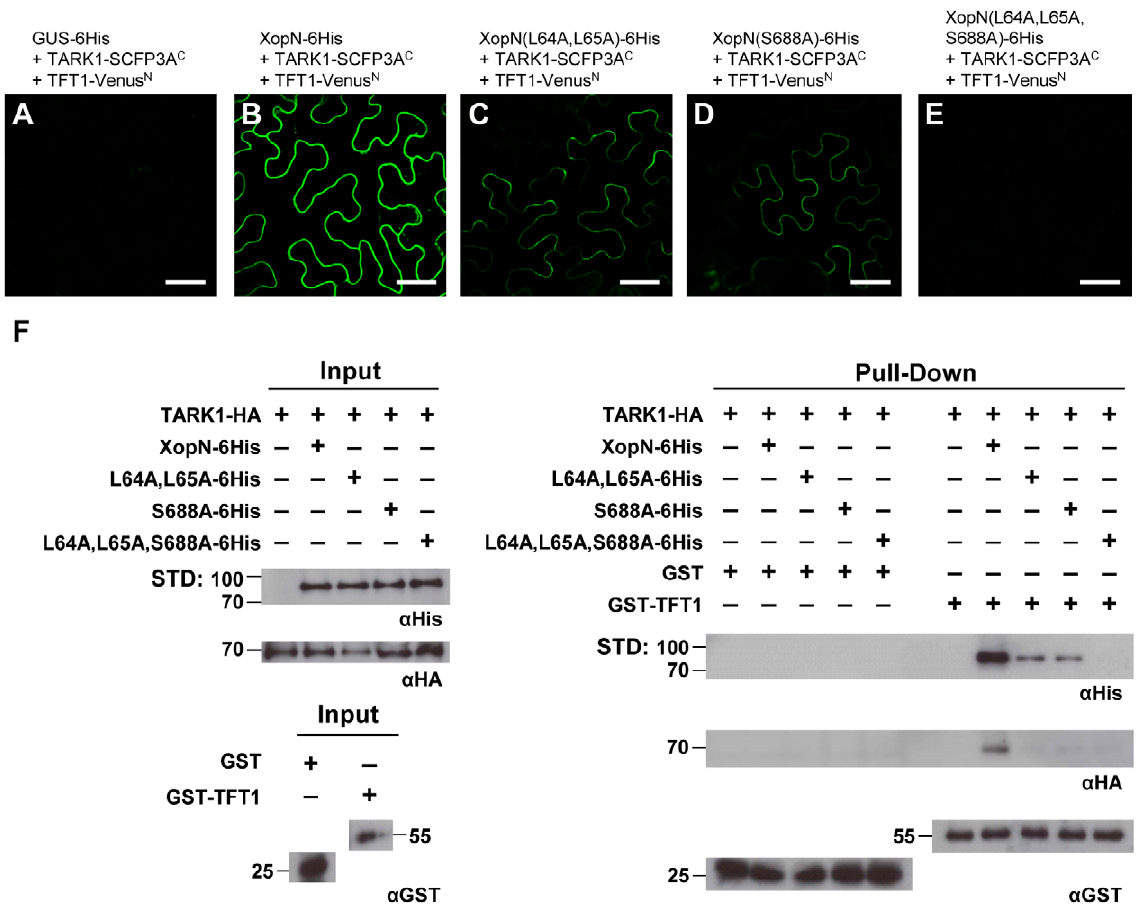
Figure 9. XopN promotes TARK1 and TFT1 binding in N.benthamiana . ( A-E ) BiFC analysis of TARK1/TFT1 interactions in N. benthamiana leaves in the presence of wild type and mutant XopN protein. Leaves were hand-infiltrated with a suspension (6 6 10 8 CFU/mL total) of three A. tumefaciens strains expressing different fusion proteins: ( A ) GUS-6His + TARK1-SCFP3A c + TFT1-Venus N ; ( B ) XopN-6His + TARK1-SCFP3A c + TFT1-Venus N ; ( C ) XopN(L64A,L65A)-6His + TARK1-SCFP3A c + TFT1-Venus N ; ( D ) XopN(S688A)-6His + TARK1-SCFP3A c + TFT1-Venus N ; ( E ) XopN-(L64A,L65A,S688A)-6His +- TARK1-SCFP3A c + TFT1-Venus N . Cells were visualized by confocal microscopy at 48 HPI at 63X. White bar=40 m m. ( F ) GST-TFT1 affinity purification of TARK1 and XopN in vitro . GST or GST-TFT1 was incubated with N. benthamiana leaf extracts containing TARK1-HA 6 vector, XopN-6His or mutant XopN-6His ( i.e. XopN(L64A,L65A)-6His, XopN(S688A)-6His, or XopN(L64A,L65A,S688A)-6His). Proteins were purified using glutathione sepharose and analyzed by immunoblot analysis using anti-His, anti-HA, and anti-GST sera. Protein input levels are shown on the left. GST and GST-TFT1 pull-downs are shown on right. Expected protein MW: GST=28 kDa; GST-TFT1=56.5 kDa; TARK1-HA=67.9 KDa; XopN(L64A,L65A)-6His, XopN(L64A,- L65A,S688A)-6His and XopN-6His=78.7 kDa. + , protein expressed; 2 , vector control. STD, molecular weight